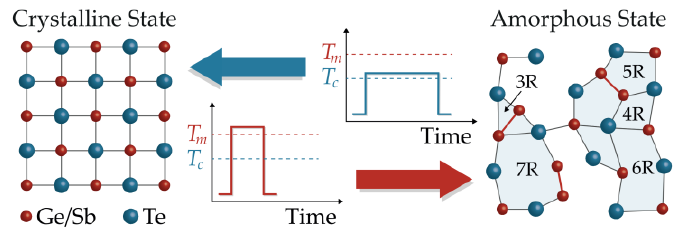
Figure 1. GeTe PCM reversible transformation using an electric pulse [8].